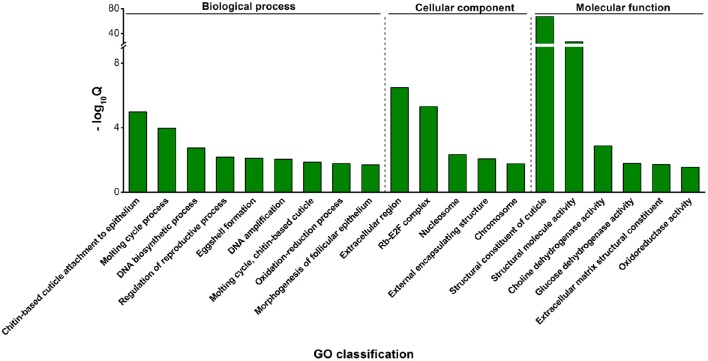
Significantly enriched GO categories among the differentially expressed genes between nymphs and adults. GO categories with Q < 0.05 were considered significantly enriched. Classification consists of three domains: biological process, cellular component and molecular function. The y-axis shows the value of −log10Q of the category. The GO term with highest −log10Q was determined the most significant enrichment.